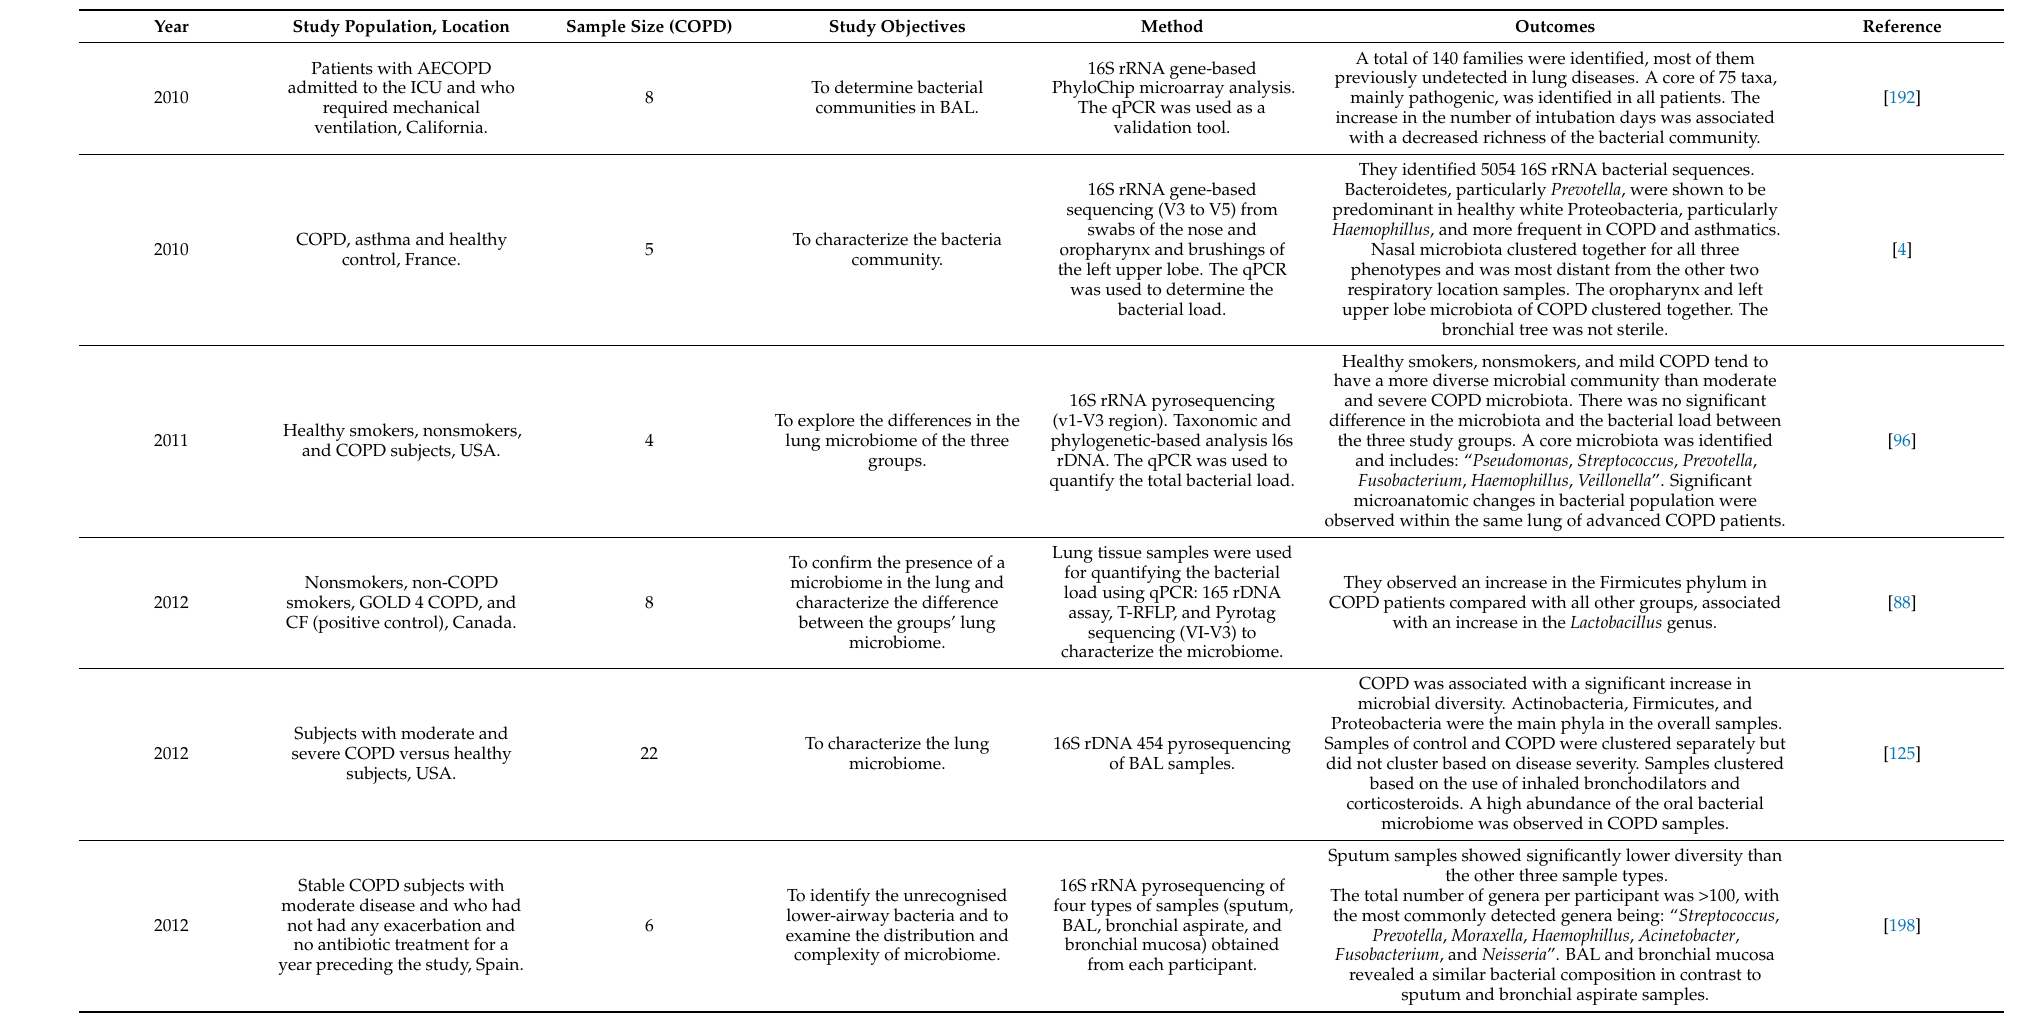
Table 4. Summary of the published studies related to the respiratory microbiome in COPD